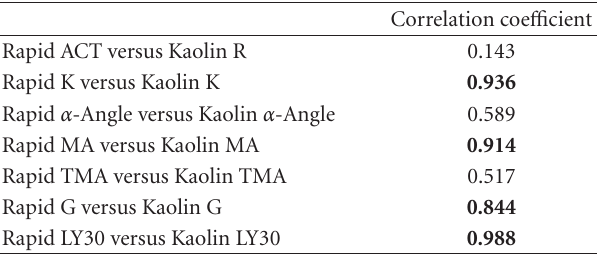
Table 5: Correlation of rapid TEG versus Kaolin